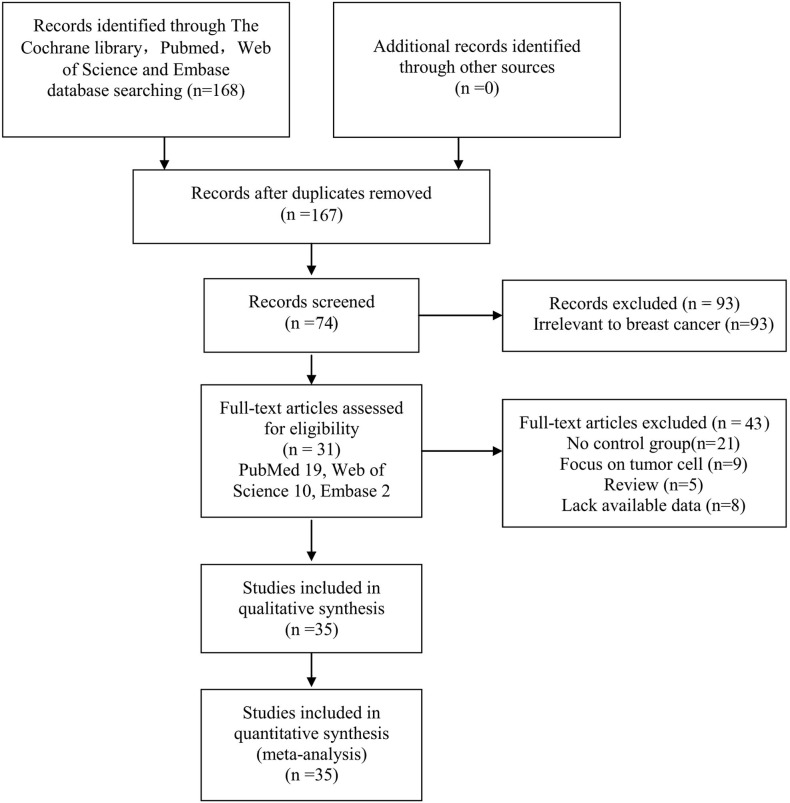
Flow chart of the collection of studies for this meta-analysis.